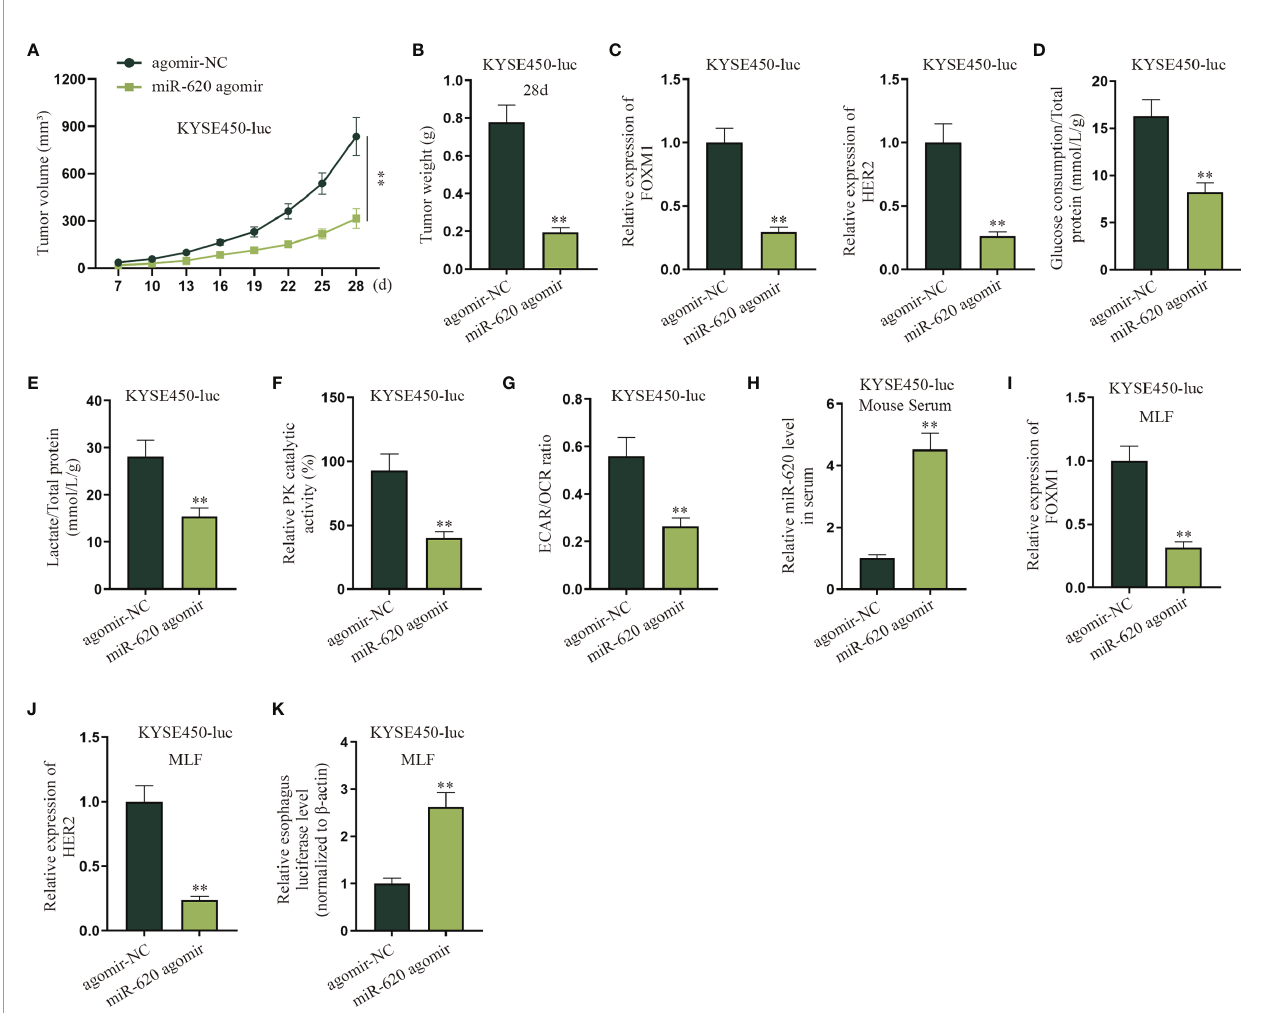
FIGURE 8 | MiR-620 inhibits the aerobic glycolysis of primary tumors and promotes ESCC metastasis. (A, B) Orthotopic mammary xenografts were constructed in mice, and the tumor volume as well as tumor weight of tumors were examined via qRT-PCR after miR-620 was overexpressed. (C) qRT-PCR was utilized to detect the expression of FOXM1 and HER2 in KYSE450-luc cells upon miR-620 overexpression. (D – G) qRT-PCR was utilized to test the glucose consumption, total lactate protein, relative PK catalytic activity, and the ECAR/OCR ratio in miR-620-overexpressed KYSE450-luc cells. (H) The expression of miR-620 in serum was measured by qRT-PCR in miR-620-overexpressed KYSE450-luc mouse serum. (I, J) The expression of FOXM1 and HER2 in MLF upon miR-620 overexpression was detected by qRT-PCR. (K) qRT-PCR was utilized to measure the relative MLF luciferase level in the xenograft tumors treated with enhanced miR-620 expression. ** p <